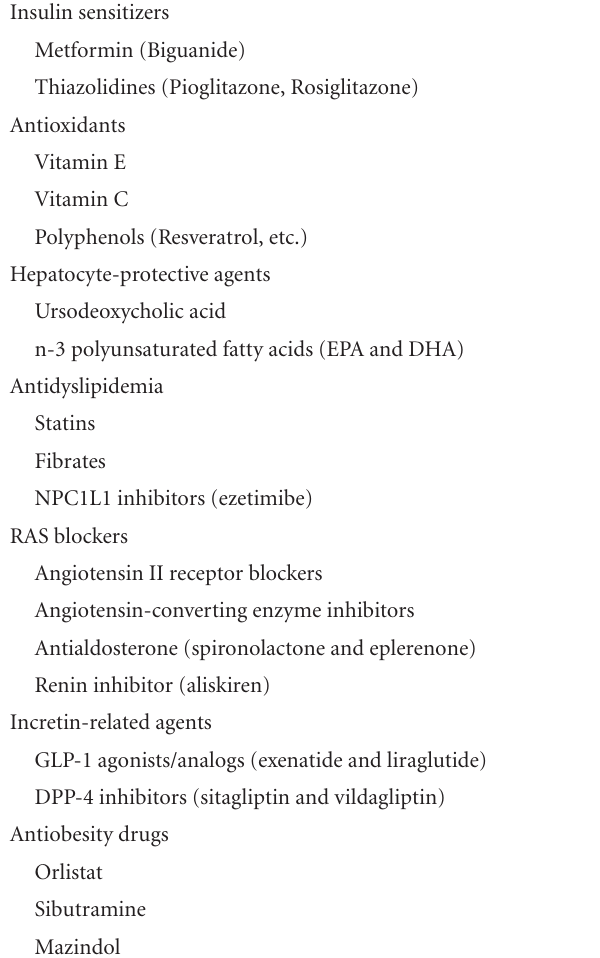
Table 1: List of drugs and agents as candidates for the treatment of